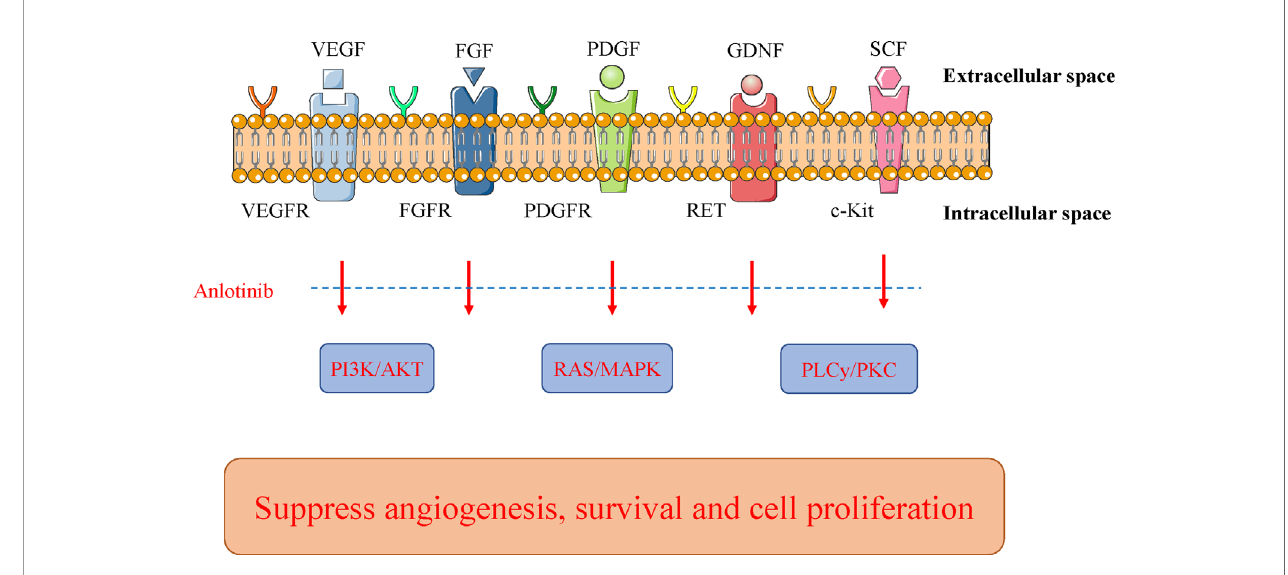
FIGURE 3 | Mechanism of action of anlotinib. Anlotinib can suppress tumor cell growth through some key pathways, including PI3K/AKT, RAS/MAPK, and PLCy/ PKC. Their key receptors include VEGFR, FGFR, and PDGFR. Anlotinib blocks the activated signals from these oncogenic receptors to the key pathways. FGFR, fi broblast growth factor receptor; GDNF, glial cell line-derived neurotrophic factor; MAPK, mitogen-activated protein kinase; PDGFR, platelet − derived growth factor receptor; PLC g , phospholipase g 1; PKC, protein kinase C; RAS, rat sarcoma protein; SCF, stem-cell factor; VEGFR, vascular endothelial growth factor